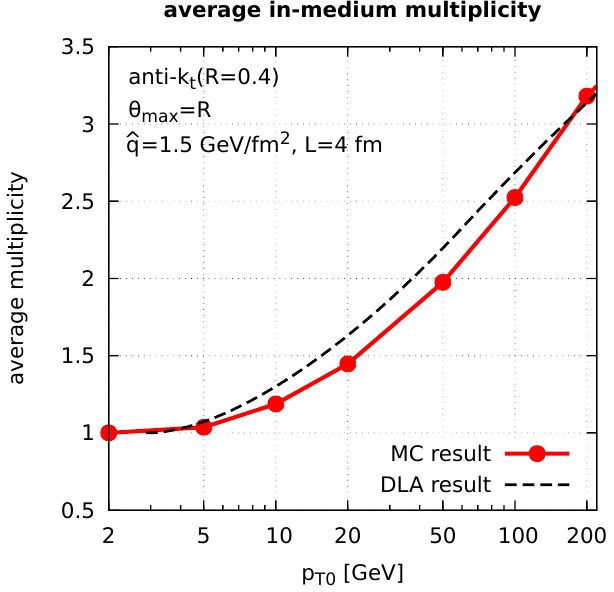
Figure 16 . The average multiplicity of partons created inside the medium via VLEs by a leading gluon with p T 0 = 200 GeV: the full Monte Carlo results shown by (red) points are compared with a running-coupling extension of the DLA estimate in eq. (2.5), integrated over the \inside" region of the phase-space of (cid:12)gure 1.